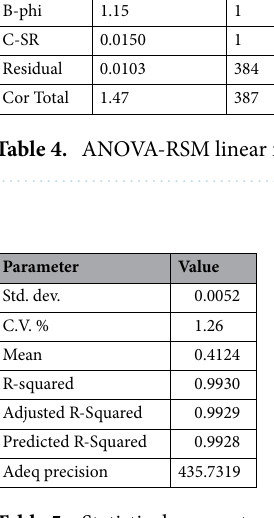
Table 5. Statistical parameters for proposed correlation by RSM.